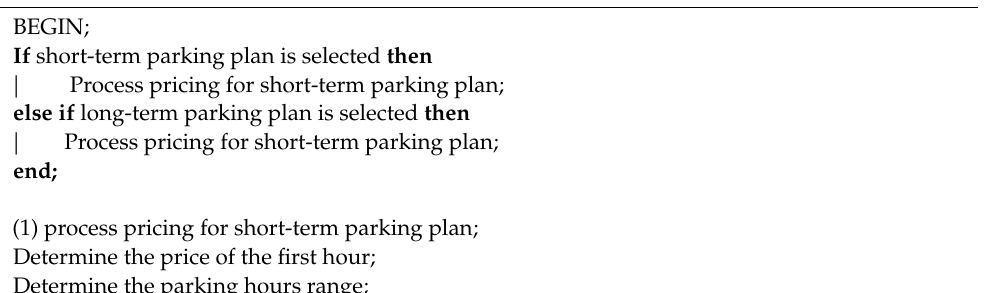
Algorithm 1: Hybrid pricing algorithm.